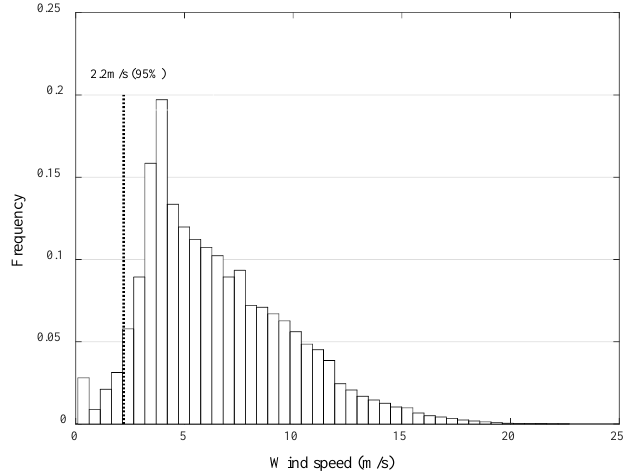
Figure 1. The frequency distribution histogram of wind speed.